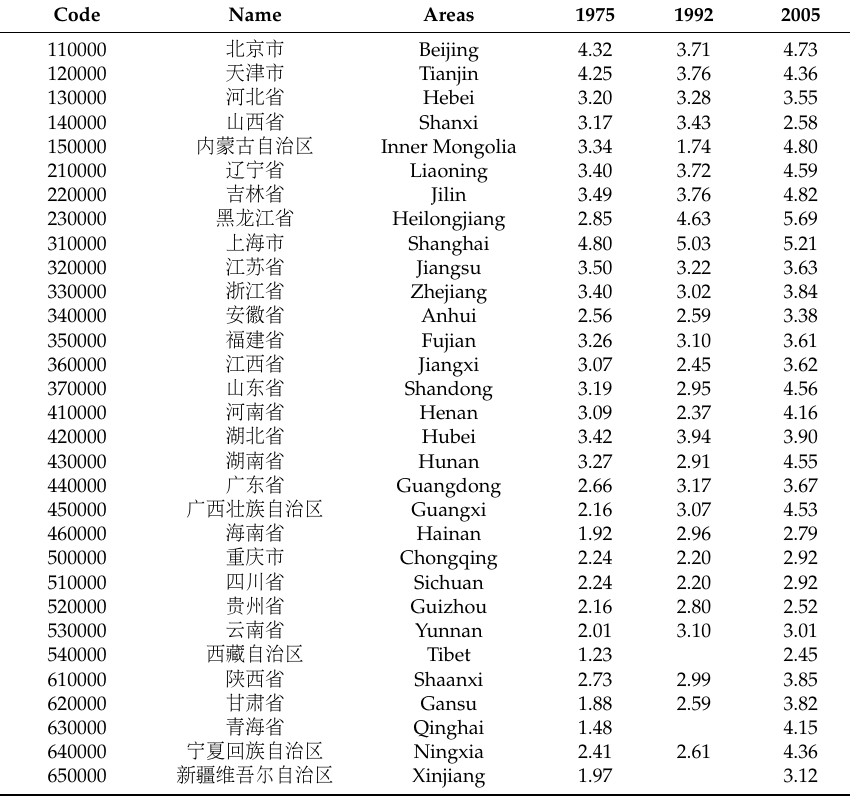
Table C1. Age-standardized mortality rate of breast cancer by province as recorded by three mortality surveys in China: 1973–1975, 1990–1992 and 2004–2005.